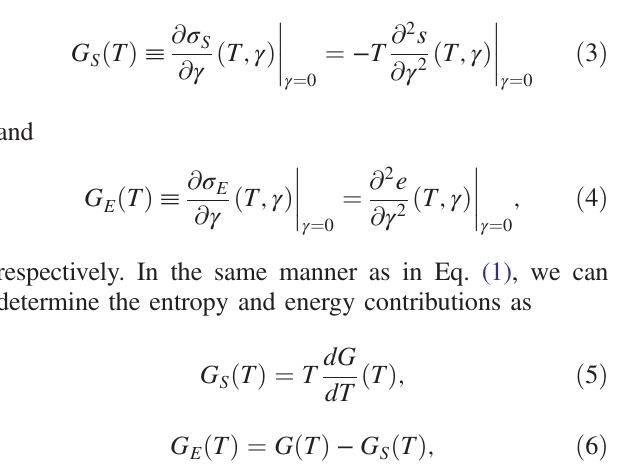
(red dashed E is a significant E